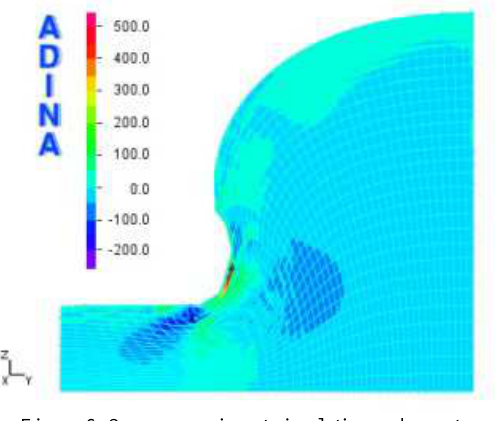
Figure 6. Creep experiment simulation – shear stress distribution [Pa]